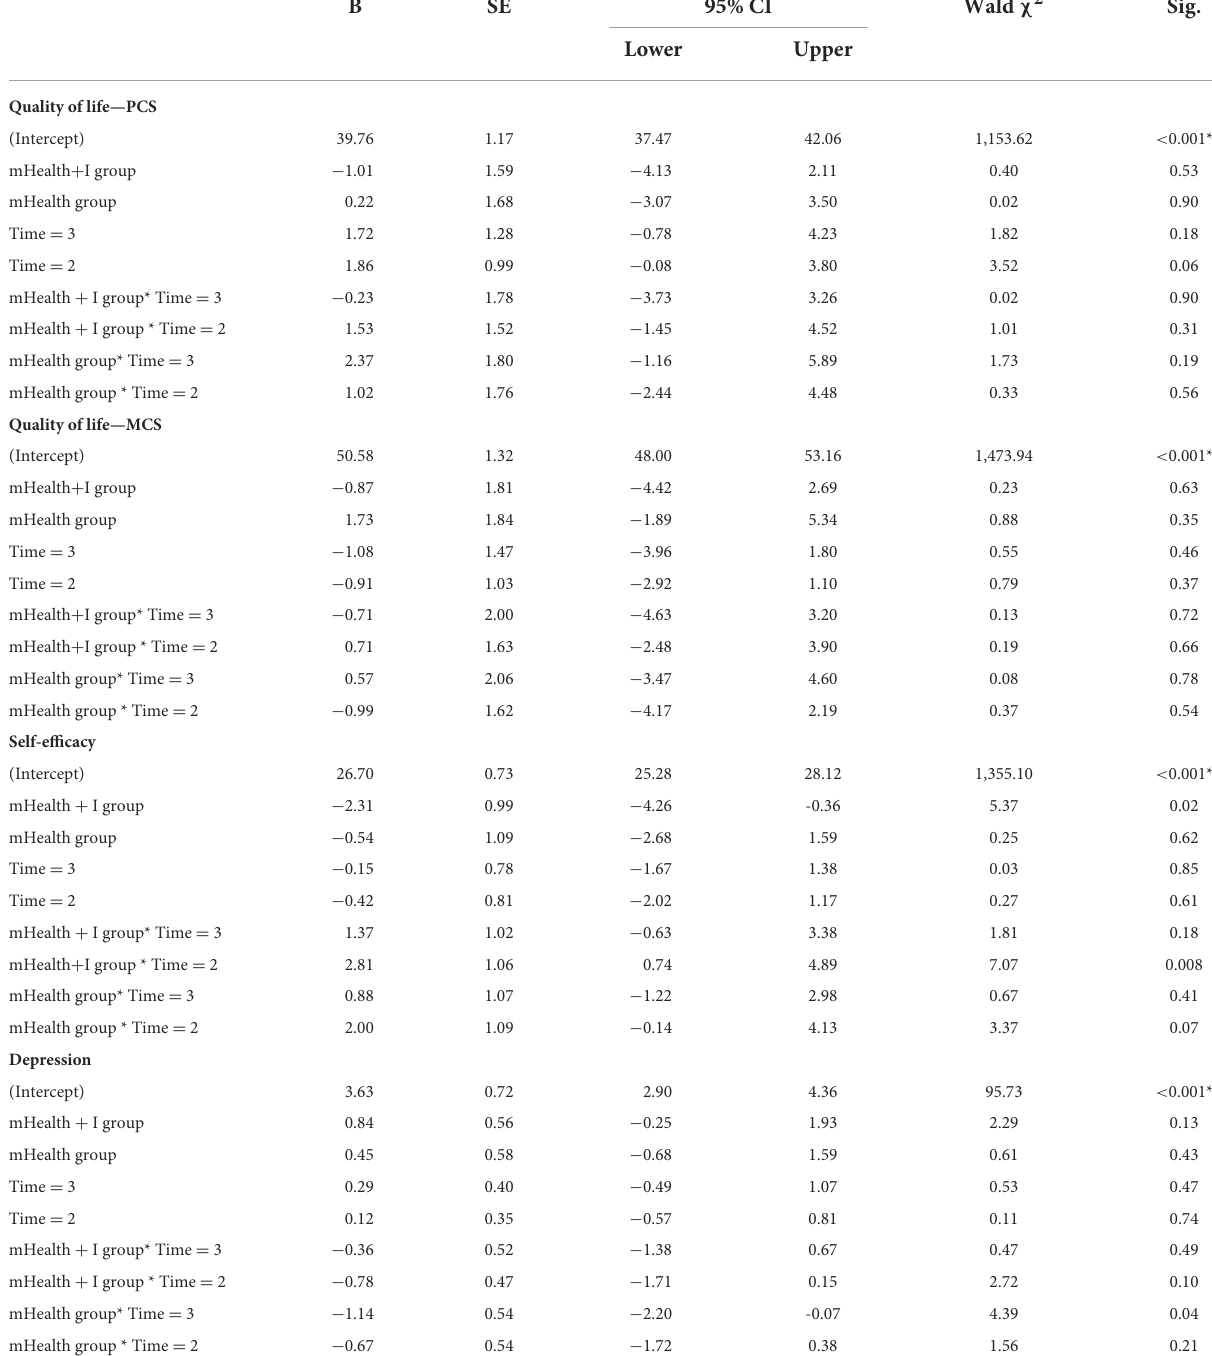
TABLE 3 Parameter estimates of outcomes. B SE 95% CI Wald χ 2 Sig. Lower